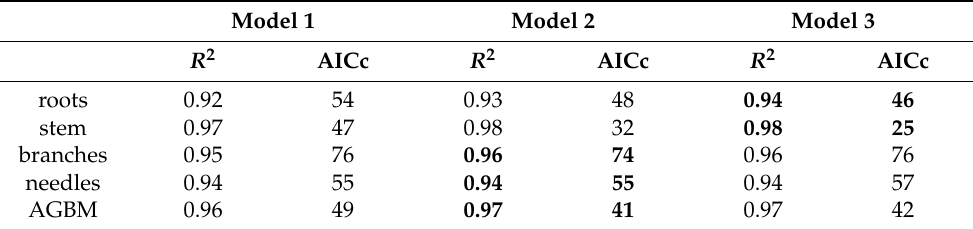
AICc values of the best model are shown in bold for each